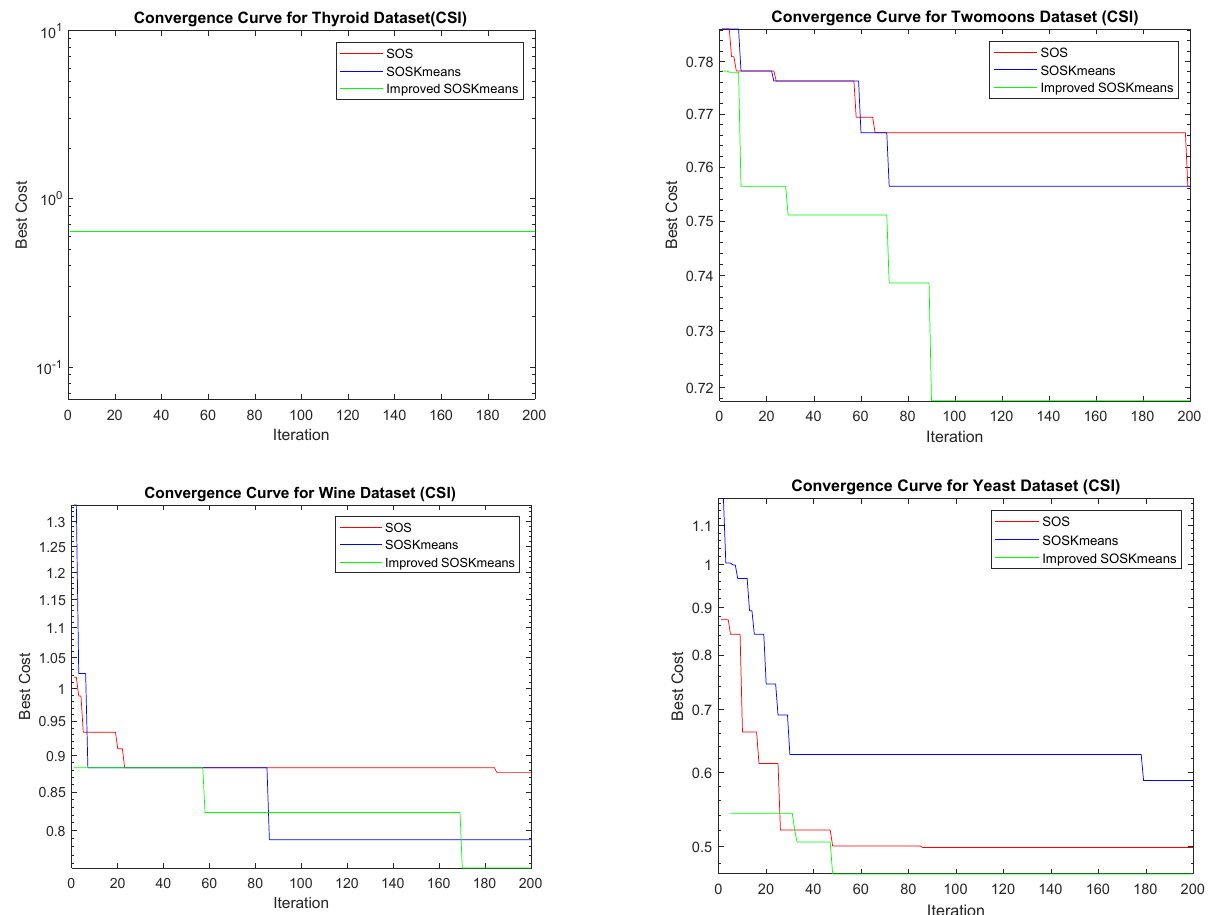
Figure 9. Convergence curves for the 12 datasets under the CS index.